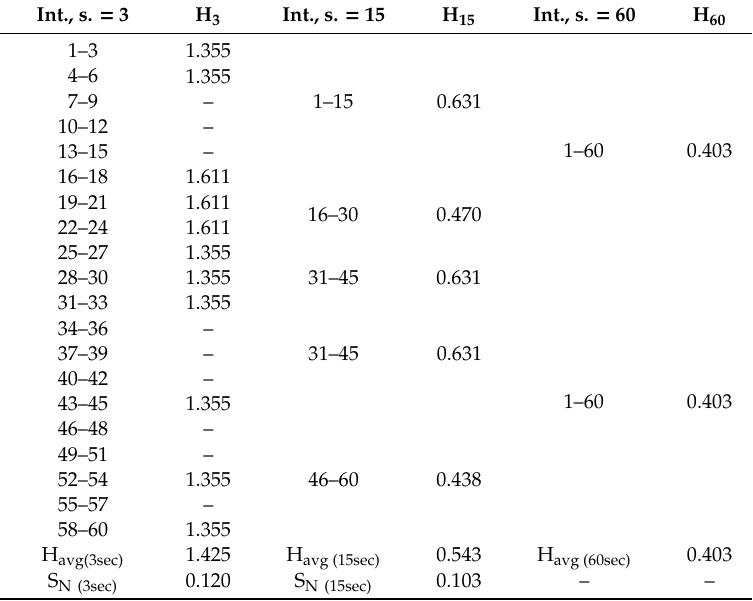
Figure 23. Throughput monitoring, in the transmission of legitimate and non-legitimate traffic (Non-Spoofed UDP(User Datagram Protocol) Floods attack) using the SolarWinds DPI system. Table 3. Tables of subscribers for UDP packets for "normal"